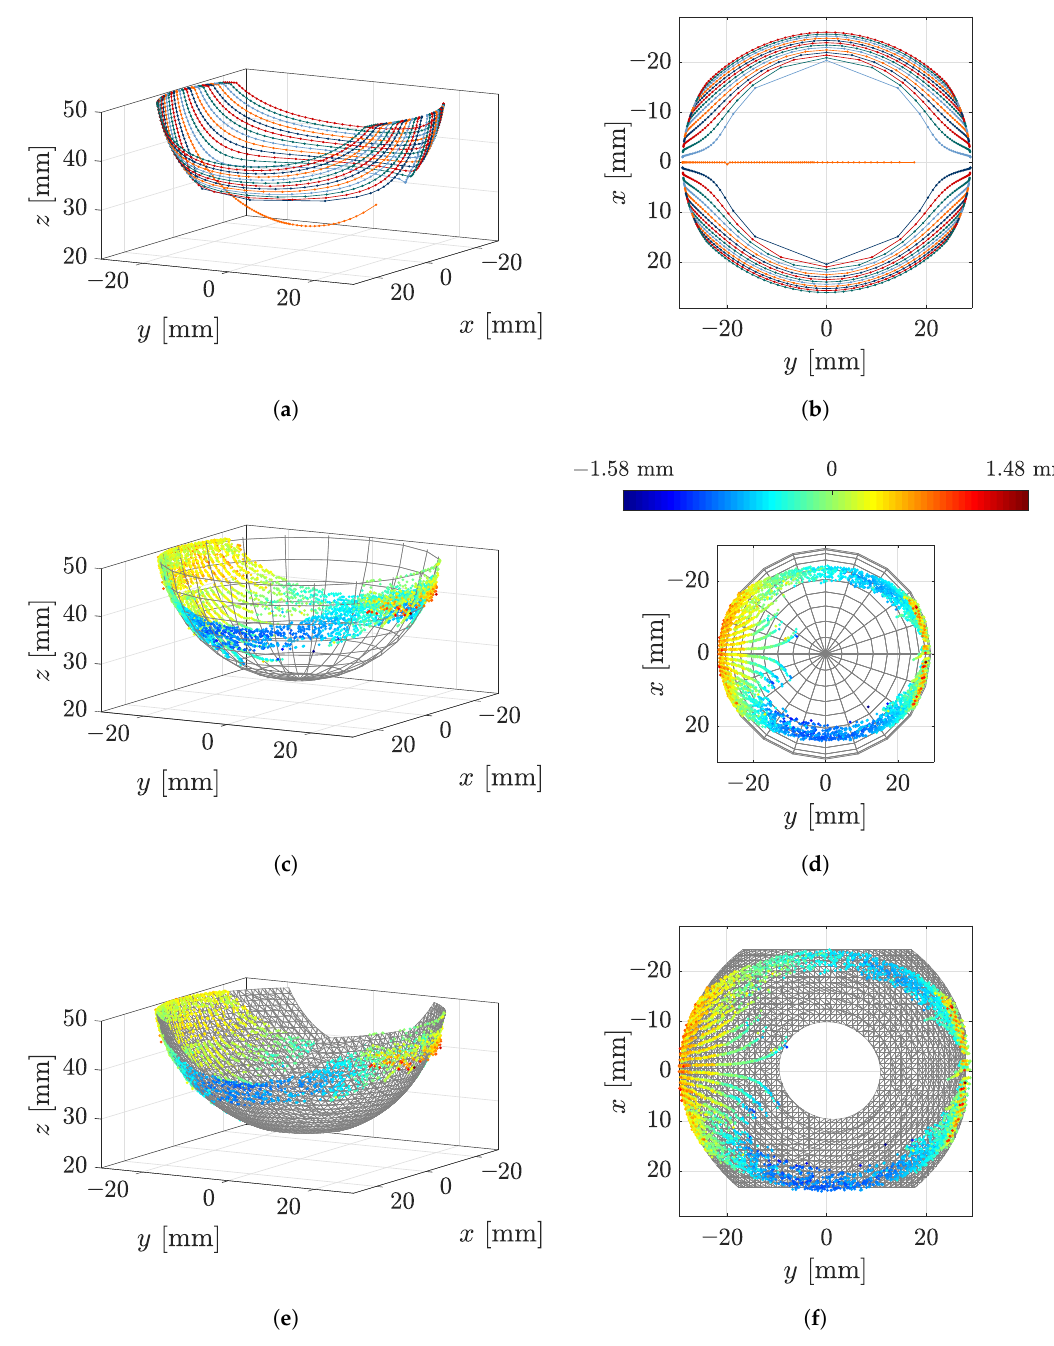
Figure 12. Object reconstruction: ( a , b ) reconstructed contact points based on simulated data (each connected sequence of points results from one scanning sweep); ( c , d ) reconstructed contact points based on experimental data superimposed with the original object shape (the color of each point indicates the reconstruction error); ( e , f ) fitted surface providing a tactile image based on the reconstructed contact points and the corresponding force